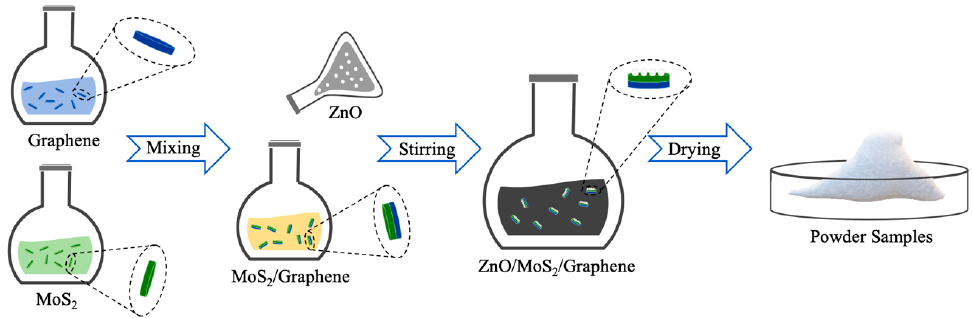
Figure 1. Schematics of manufacture processes of zinc oxide (ZnO)/molybdenum disulfide (MoS2)/graphene heterostructures.